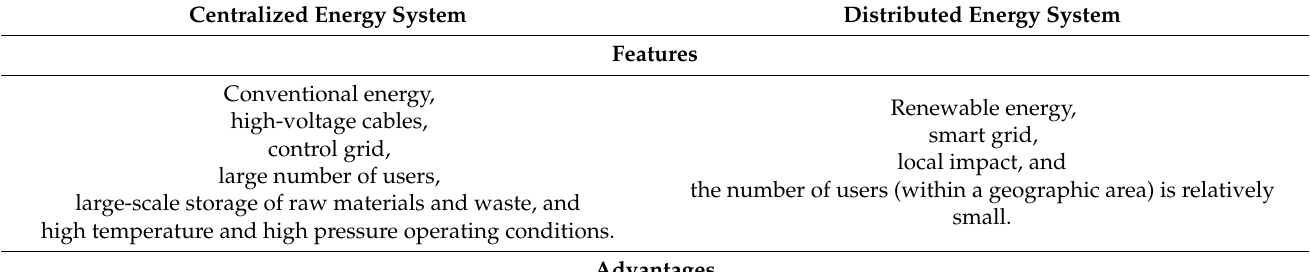
Table 1. Comparison of Centralized and Distributed Energy